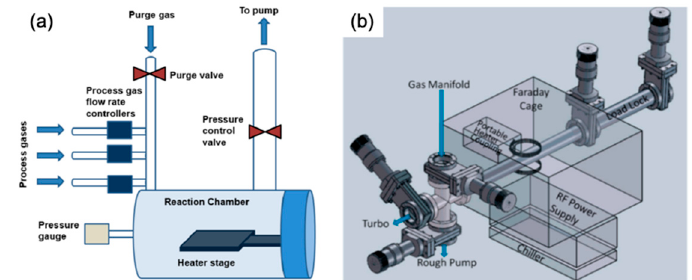
Figure 9. ( a ) a scheme of the cold wall CVD system used for graphene growth [81] and ( b ) the cold wall CVD system based on radio frequency magnetic inductive heating (reprinted with permission from [85]).